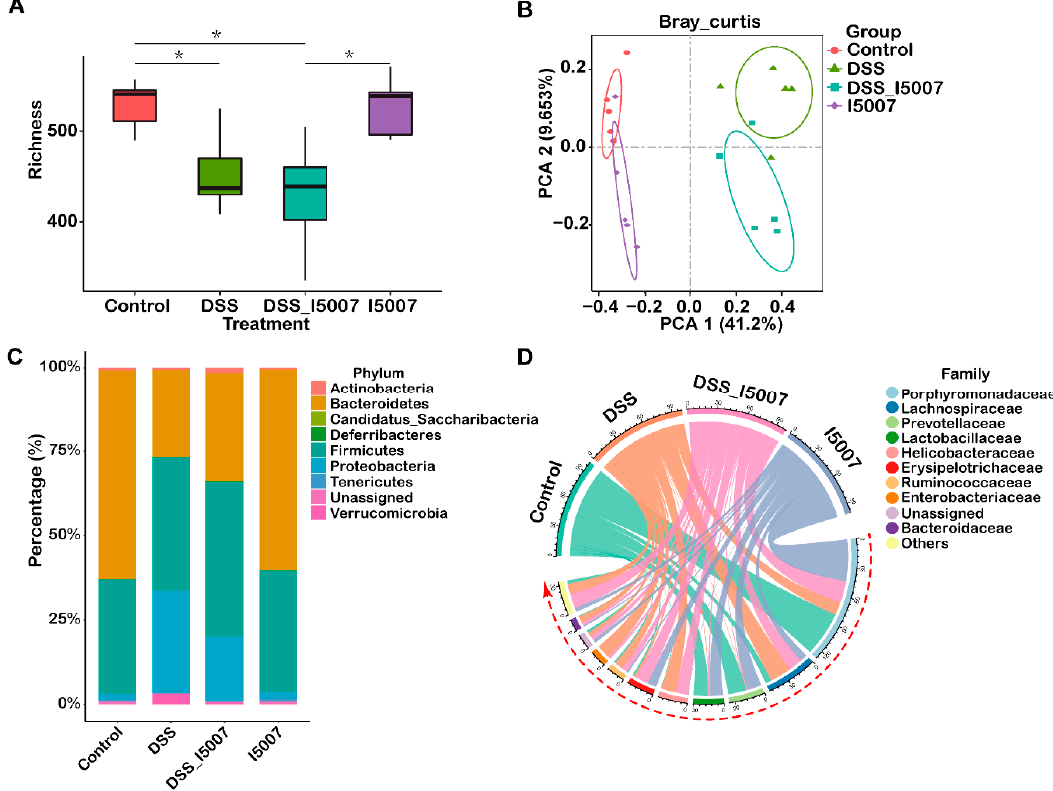
Figure 4. Impact of L. reuteri I5007 pretreatment on colonic microbiota composition. ( A ) Boxplot of microbiota alpha diversity indicated by the richness index; ( B ) principal component analysis (PCoA) plot of microbiota based on Bray ‐ Curtis dissimilarity; ( C ) histogram of structural composition of microbiota at the phylum level; ( D ) chord diagram of the structural composition of microbiota at the family level.